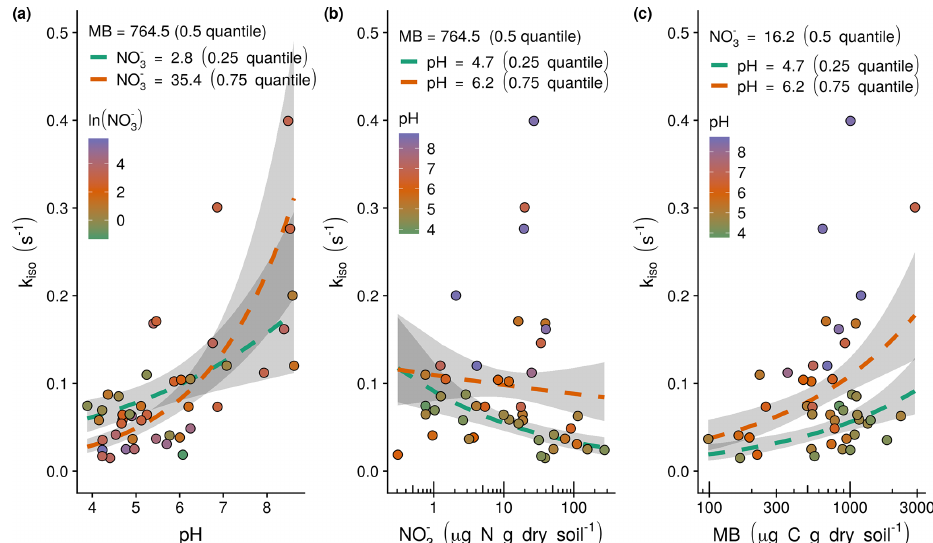
Figure 3. Observed (points) and modelled relationships following Eq. (6) (dashed lines) between the rate of oxygen isotope exchange ( k iso ) and soil pH, exchangeable NO − and microbial biomass (MB): (a) the positive relationship between k iso and soil pH with model response 3 as a function of the shown range in soil pH calculated with median microbial biomass and lower quartile (green dashed line) and upper quartile (orange dashed line) exchangeable NO − , (b) the negative relationship between k iso and exchangeable NO − with model response as 3 3 a function of the shown range in exchangeable NO − calculated with median microbial biomass and lower quartile (green dashed line) and 3 upper quartile (orange dashed line) soil pH, and (c) the positive relationship between k iso and microbial biomass with the model response as a function of the shown range in microbial biomass calculated with median exchangeable NO − and lower quartile (green dashed line) and 3 upper quartile (orange dashed line) soil pH. Grey shaded areas indicate the 95% confidence intervals associated with model fits.